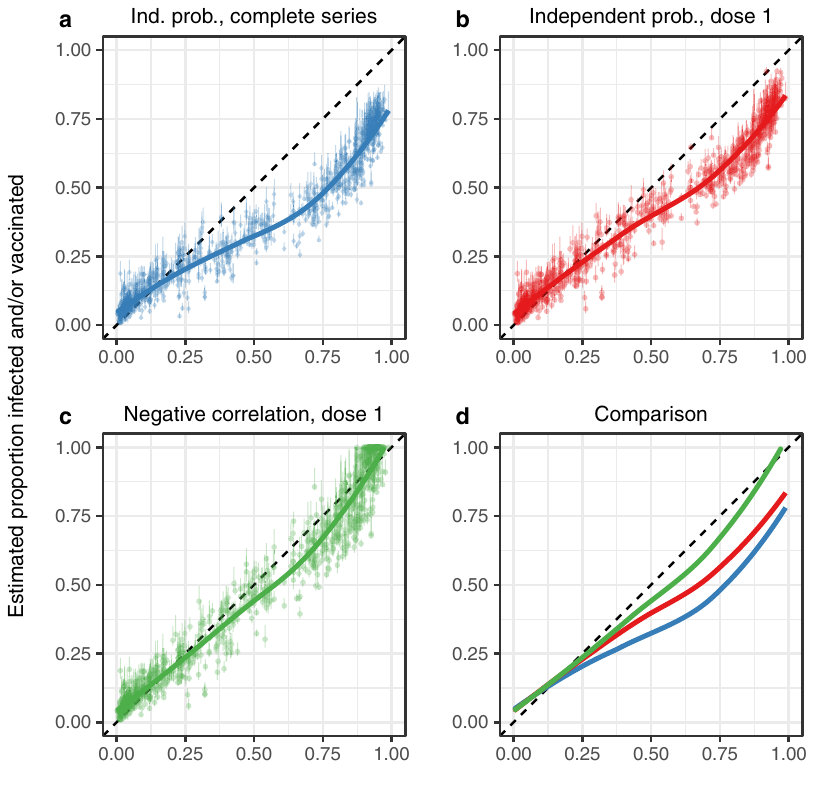
Fig.5|Comparisonofourestimatesofproportionsinfectedand/orvaccinated with the blood donors anti-S seroprevalence estimates. Comparing estimated proportions infected and/or vaccinated (EPIV) using the best waning logistic regression (Table 1) with estimated anti-S seroprevalence from blood donor sam- ples.Theseroprevalencefromtheblooddonorsamplesincludesbothinfectedand vaccinated individuals, and our EPIV combines estimated proportion infected (adjustingforassayuseandwaning)withtheproportionvaccinated.Thicklinesare LOESS fi tstothedatapointsshown,andthinverticallinesshowuncertaintyinEPIV values. That uncertainty comes from our estimated proportions infected, due to